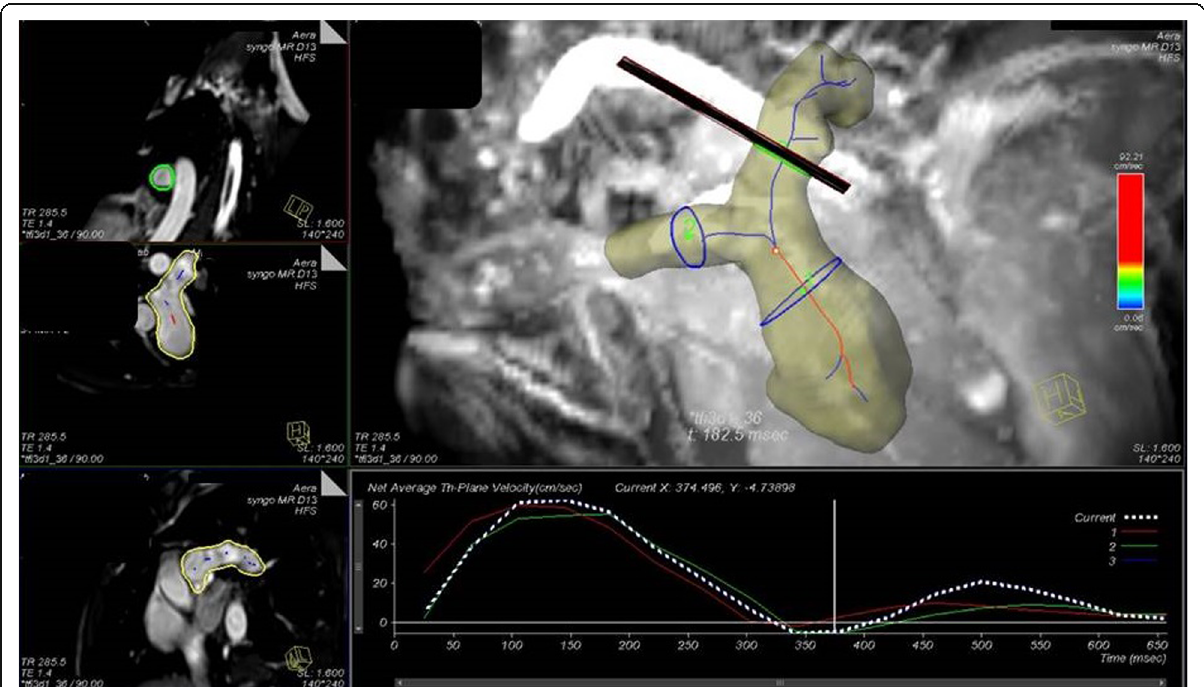
Fig. 4 4D-CMR flow of the MPA, RPA, and LPA in a surgically repaired TOF patient with RVOT patch showing the offline planning of areas of interest at the proximal segments of these vessels to acquire all flow data and flow-time curves showed. CMR: cardiac magnetic resonance, MPA: main pulmonary artery, RPA: right pulmonary artery, LPA: left pulmonary